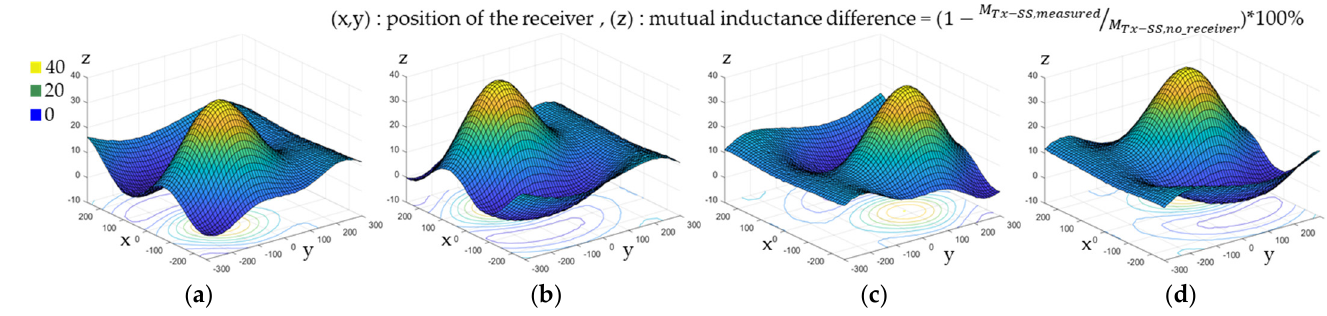
Figure 9. Tendency of the mutual inductance difference of each SS coil according to the position of the receiver. ( a ) SS coil 1. ( b ) SS coil 2. ( c ) SS coil 3. ( d ) SS coil 4.